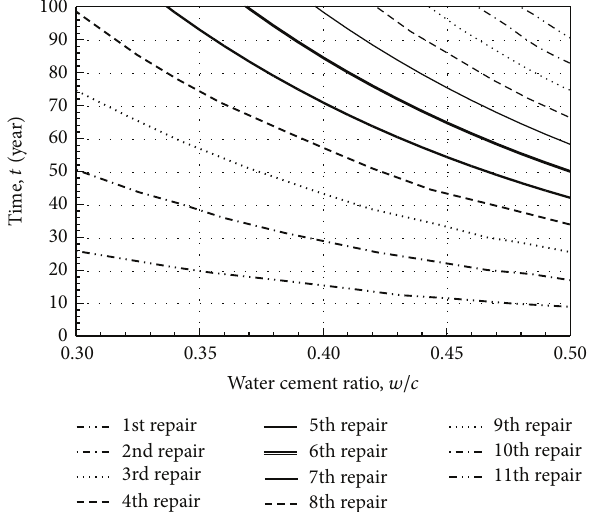
Figure 8: Effect of the water cement ratio on the repair schedule of the present concrete column.